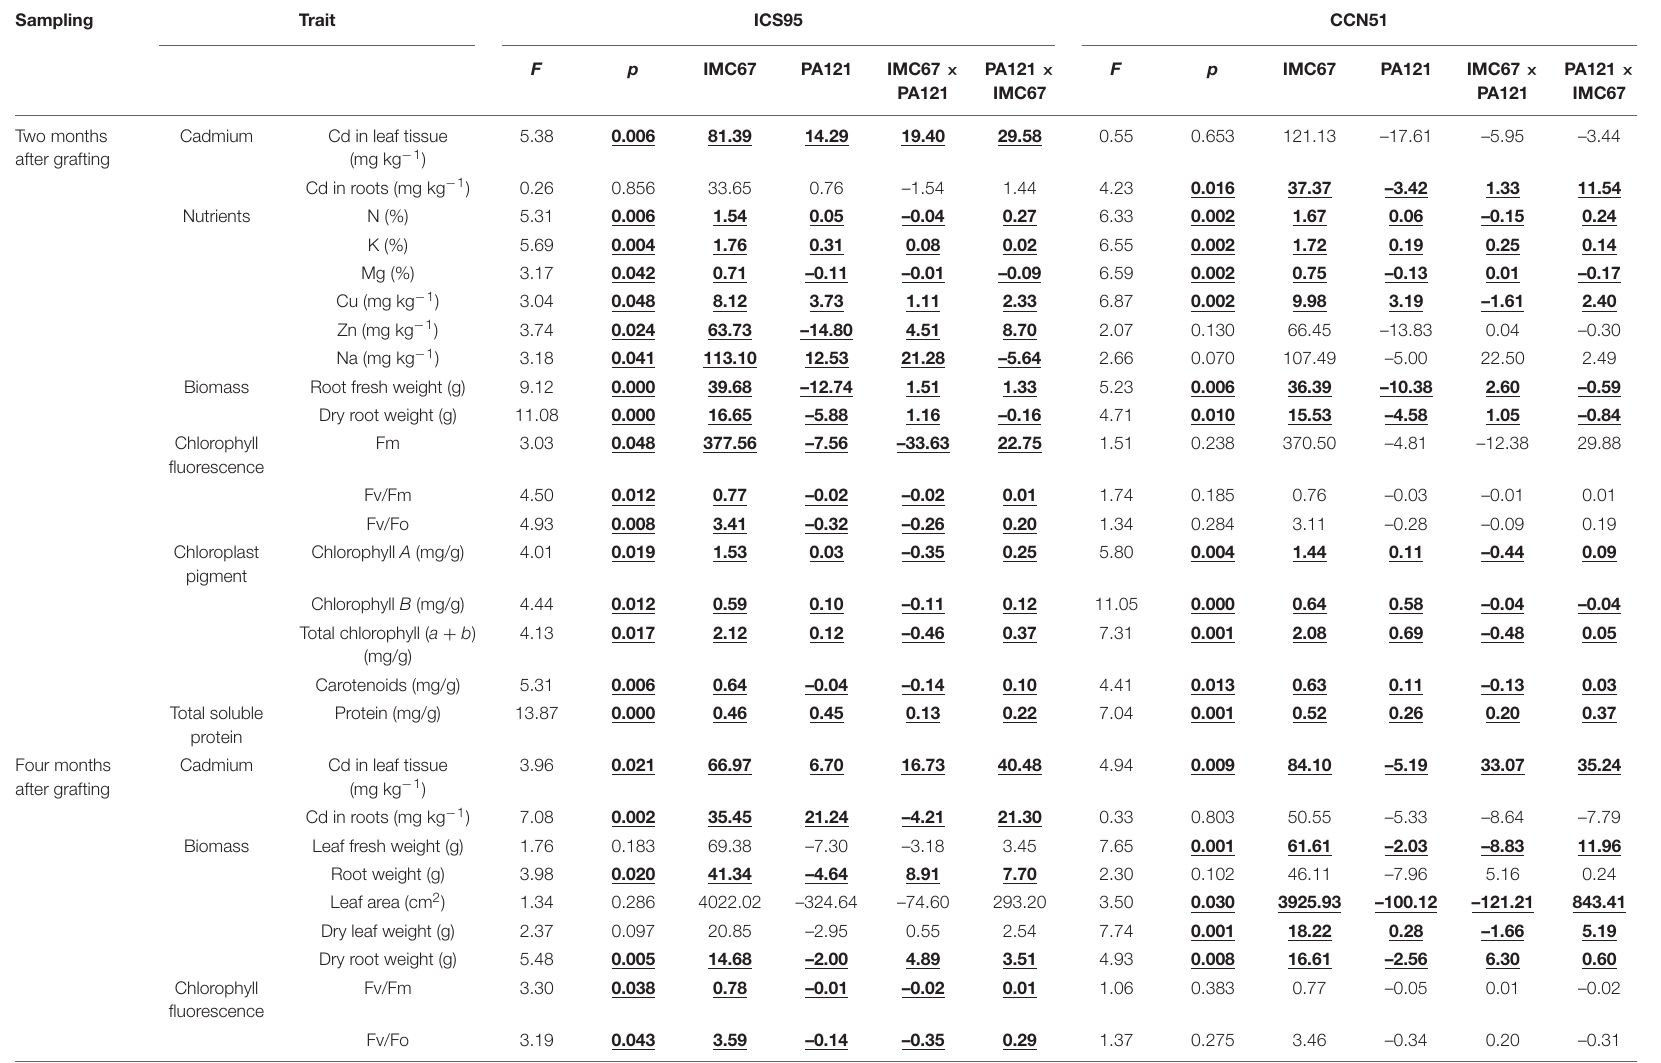
TABLE 2 | Specific combining abilities in cacao seedling rootstocks from controlled crosses 2 and 4 months after grafting with the ICS95 and CCN51 scions.